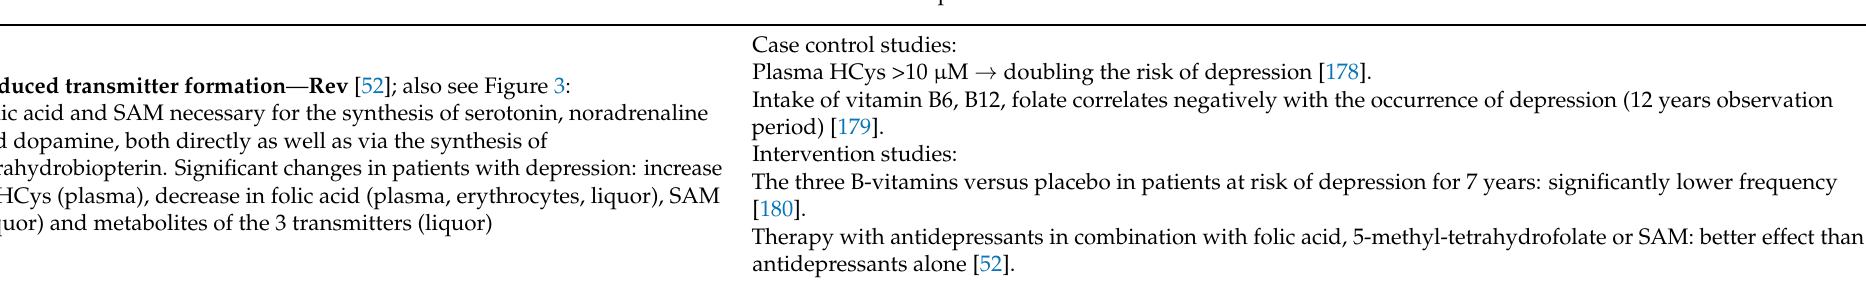
Table A4. Depression.